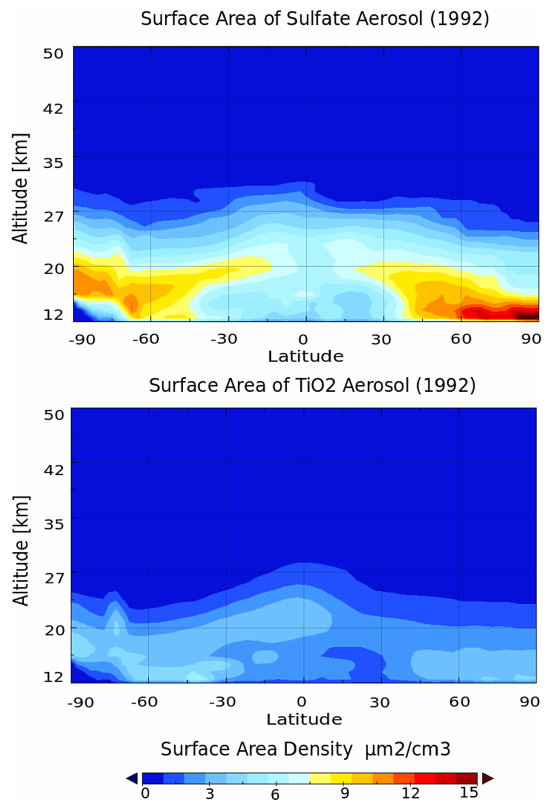
Figure 5. Surface area density (µm 2 cm − 3 ) of sulfate particles after the Mt Pinatubo eruption (top panel) and of TiO 2 particles (bottom panel) which generate the same radiative effect as the sulfate parti- cles in the top panel (Pope et al., 2012) and which were used in the simulations shown in Fig.